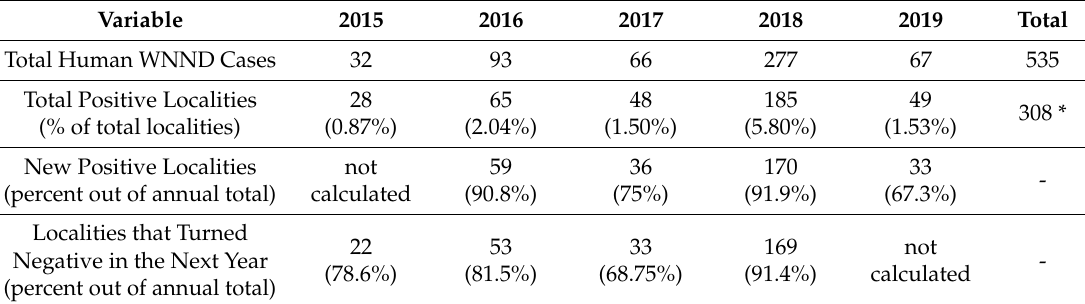
Table 1. Number of human WNND cases, positive localities, and trend overview.